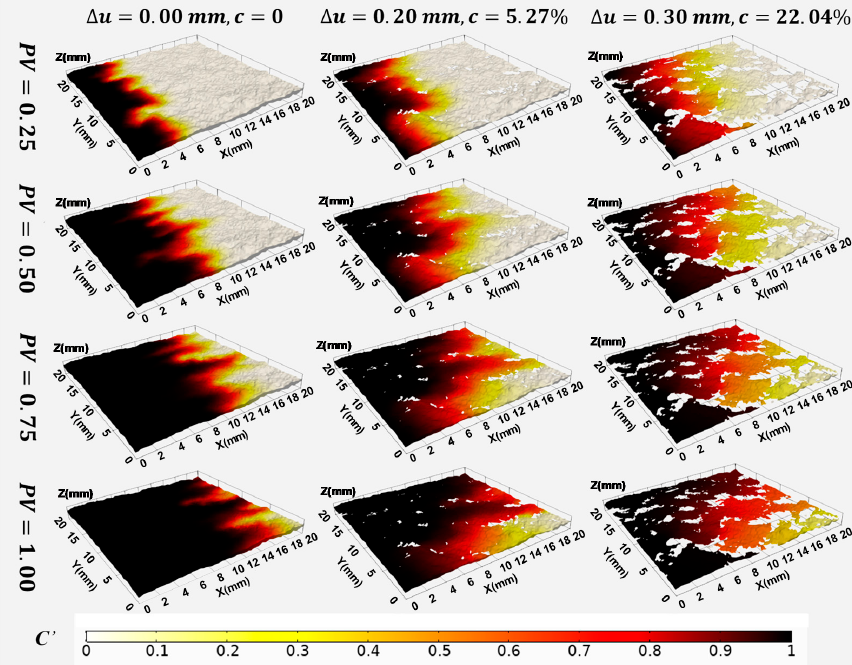
Figure 13. Evolutions of the concentration field for fractures of Δ u = 0.00, 0.20, and 0.30 mm at PV = 0.25, 0.50, 0.75 and 1.0 with H = 0.50.